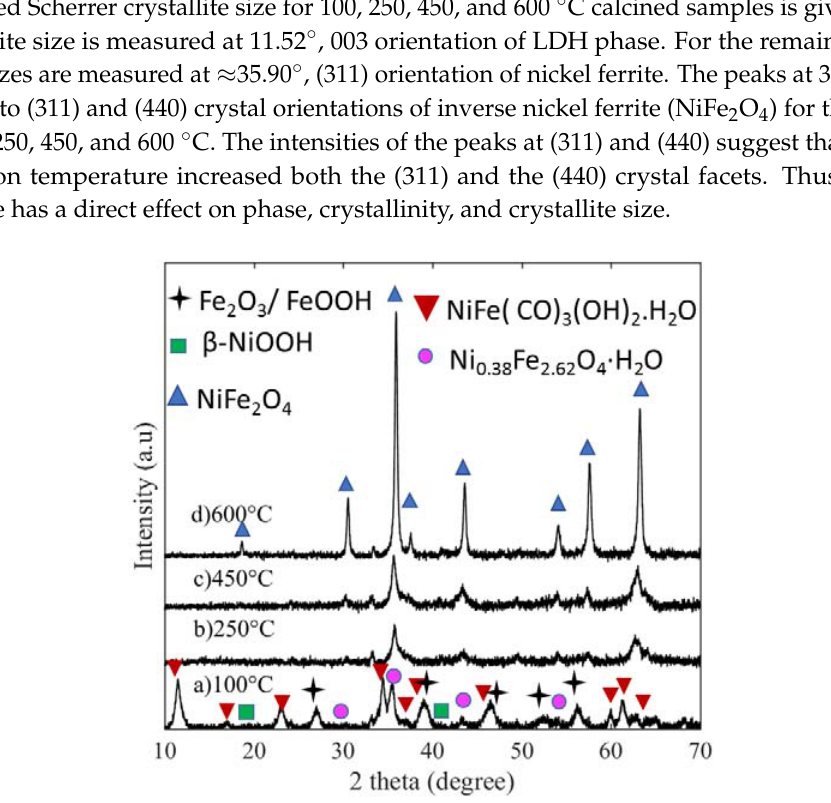
Figure 1. Diffractograms of the NiFe oxides at the different annealing temperatures. Table 1. N 2 isotherm characteristics of the Ni Fe oxide at different